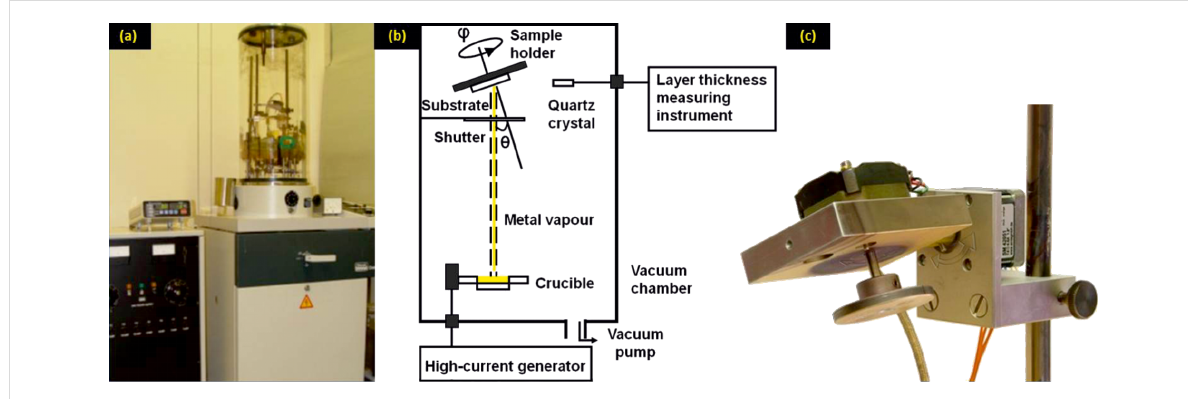
Figure 2: Tilted angle evaporation setup. (a) We modify an Edwards E306 evaporation machine by using a 60 cm high glass cylinder in order to allow for a larger crucible-sample distance during evaporation. This warrants a point-like and straight evaporation. (b) Schematic setup of the evaporation, with the two additional stepper motors (c) that can rotate the substrate during evaporation around a polar angle φ and an azimuthal angle θ . The elec- tric leads are connected by a vacuum feedthrough to an external controller outside the vacuum chamber and controlled by a computer program that allows for different evaporation